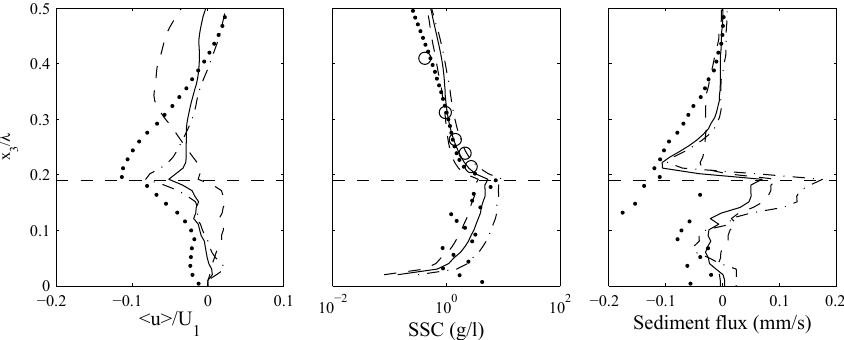
Figure 10. Vertical profiles of ripple-averaged horizontal velocity, suspended sediment, and suspended sediment flux in the 10th period of oscillation, including experimental measurements (PIV and ABS – dots; SSC measured by transverse suction system – circles), and the LES predictions for varying z 0 ( d 50 / 12 – dashed line; d 50 / 4 – solid line; d 50 – dash-dotted line) for the 10th period of oscillation.